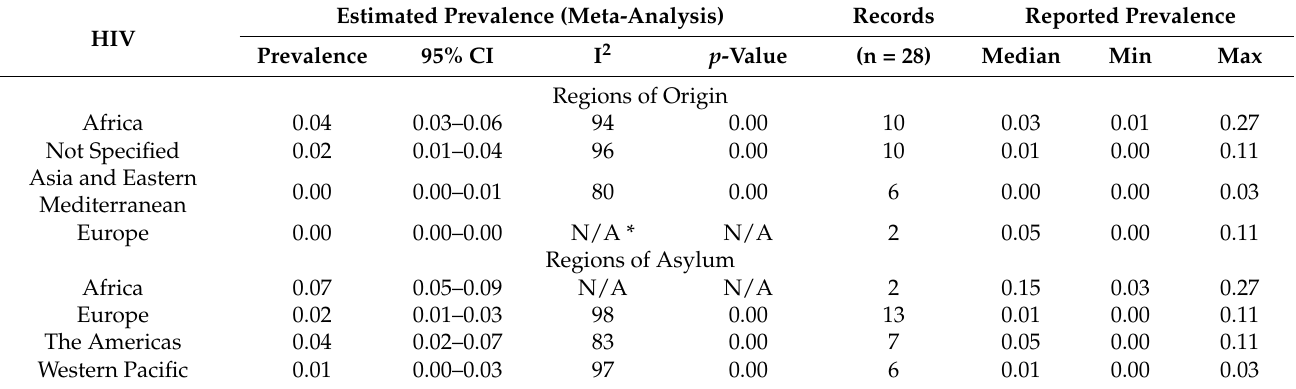
Table 6. Human immunodeficiency virus prevalence estimates, 95% confidence interval, heterogene- ity level (I 2 ), p -value, records, median, minimum, and maximum reported prevalence among refugees and asylum